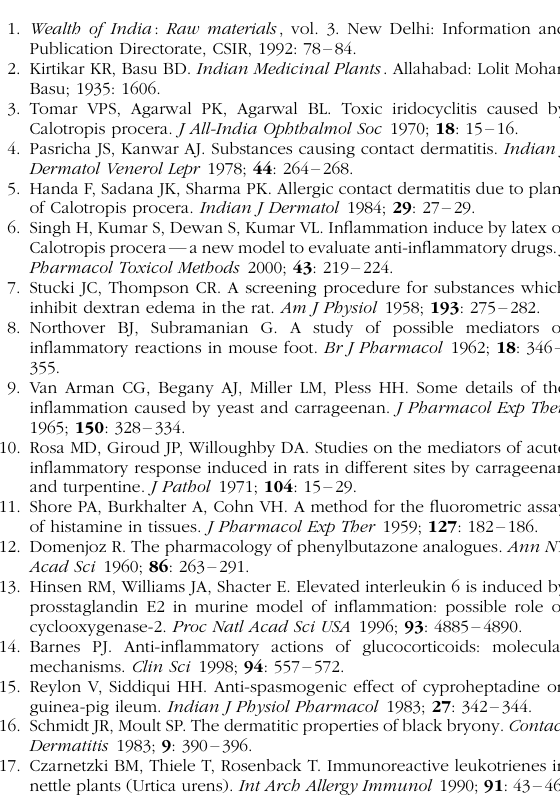
The edema volume was measured at 90 and 180 min. * p B / 0.05, ** p B /